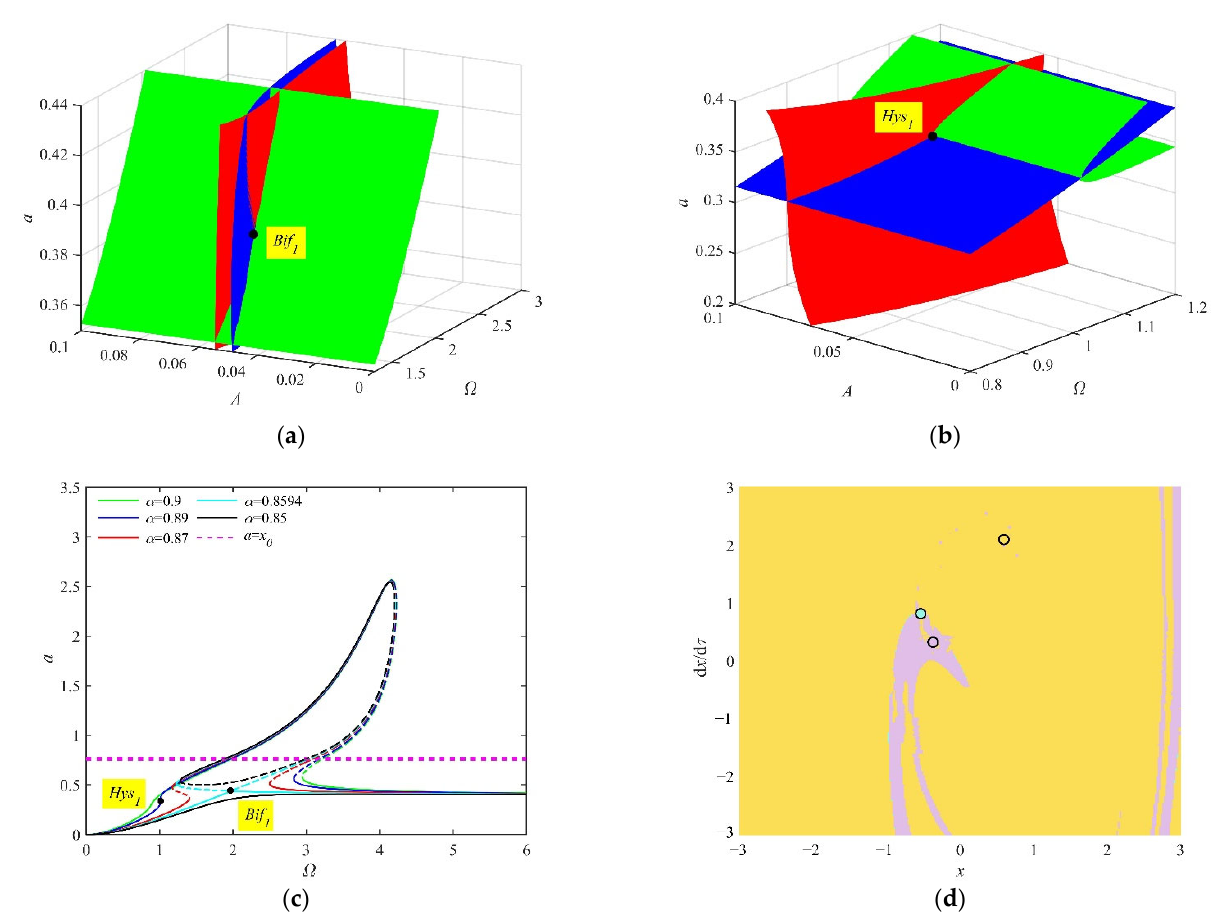
Bif ; ( b ) the hysteresis set Hys ; ( c ) the amplitude–frequency re ‐ 1 1